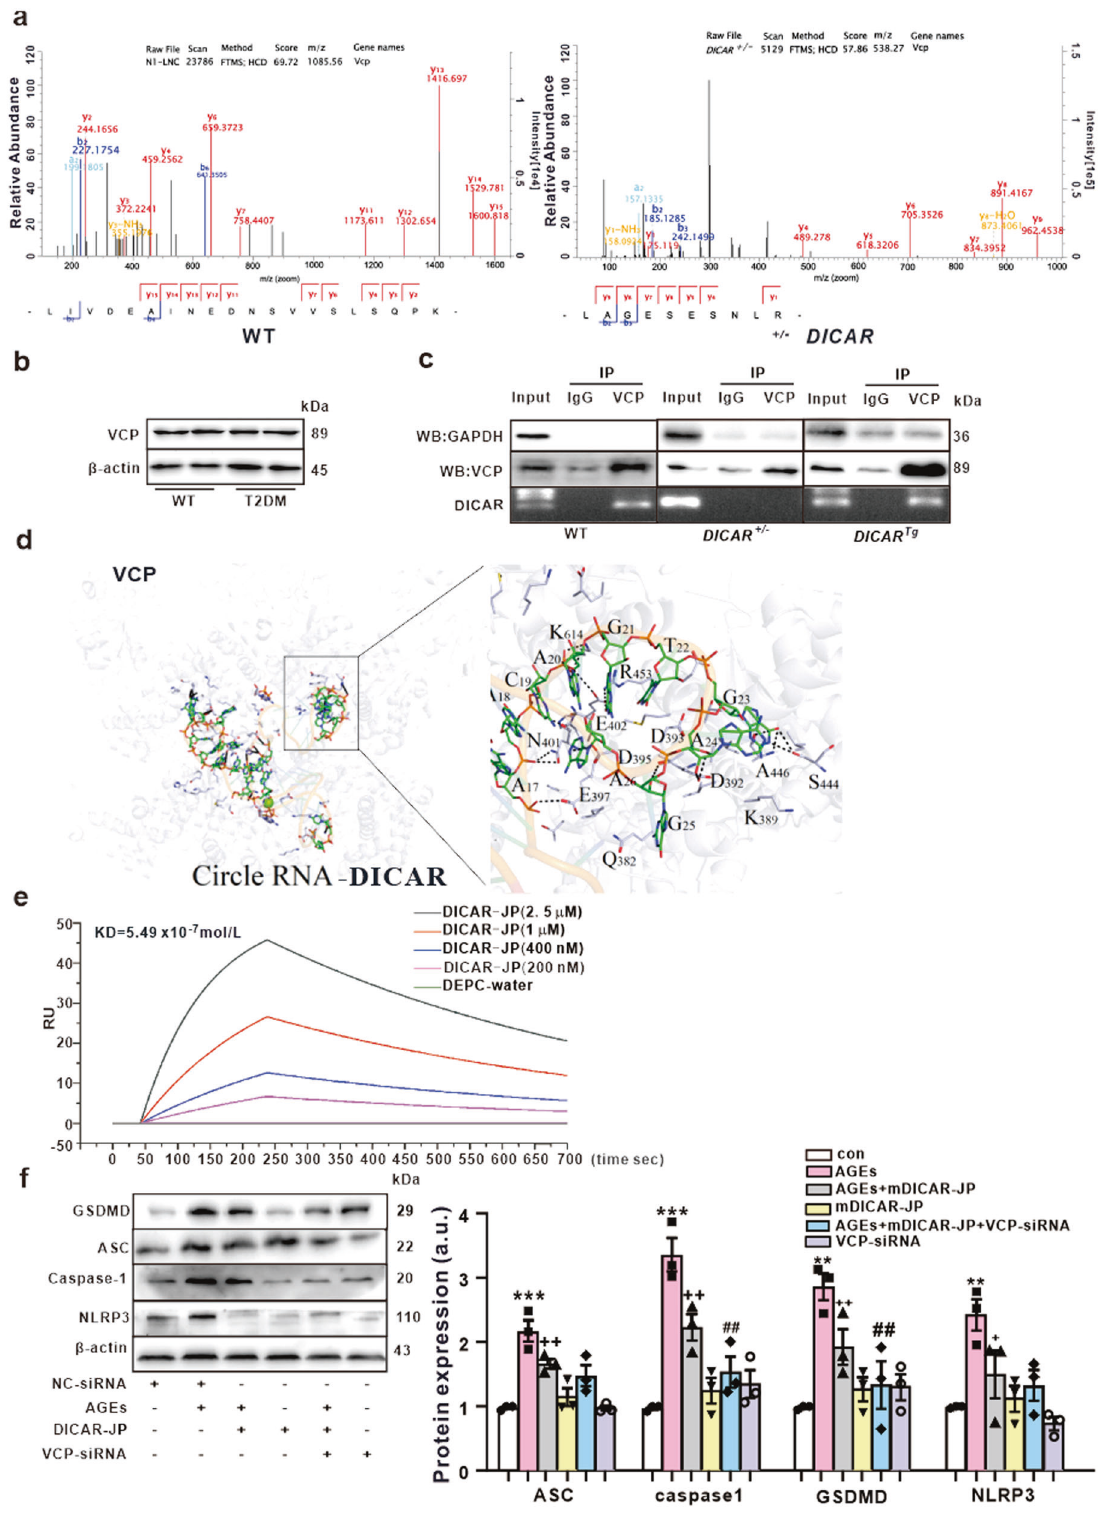
Fig. 4 Interaction between VCP and DICAR in the pyroptosis of cardiomyocytes induced by AGEs. a Representative images of VCP pulled down by DICAR probe and detected by CHIRP-MS. b Total VCP protein expression between WT and db/db mice. c RIP used to detect the combination between VCP and DICAR. d Model prediction of VCP combined with DICAR. e the KD of DICAR combined with VCP detected by SPR. f the effect of VCP-siRNA on anti-pyroptosis induced by AGEs. Data are represented as mean ± SEM. ** P < 0.01, *** P < 0.001 vs. con; + + P < 0.01 vs. AGEs (200 µg/ml, 48 h); ## P < 0.01 vs. AGEs + mDICAR-JP, n =